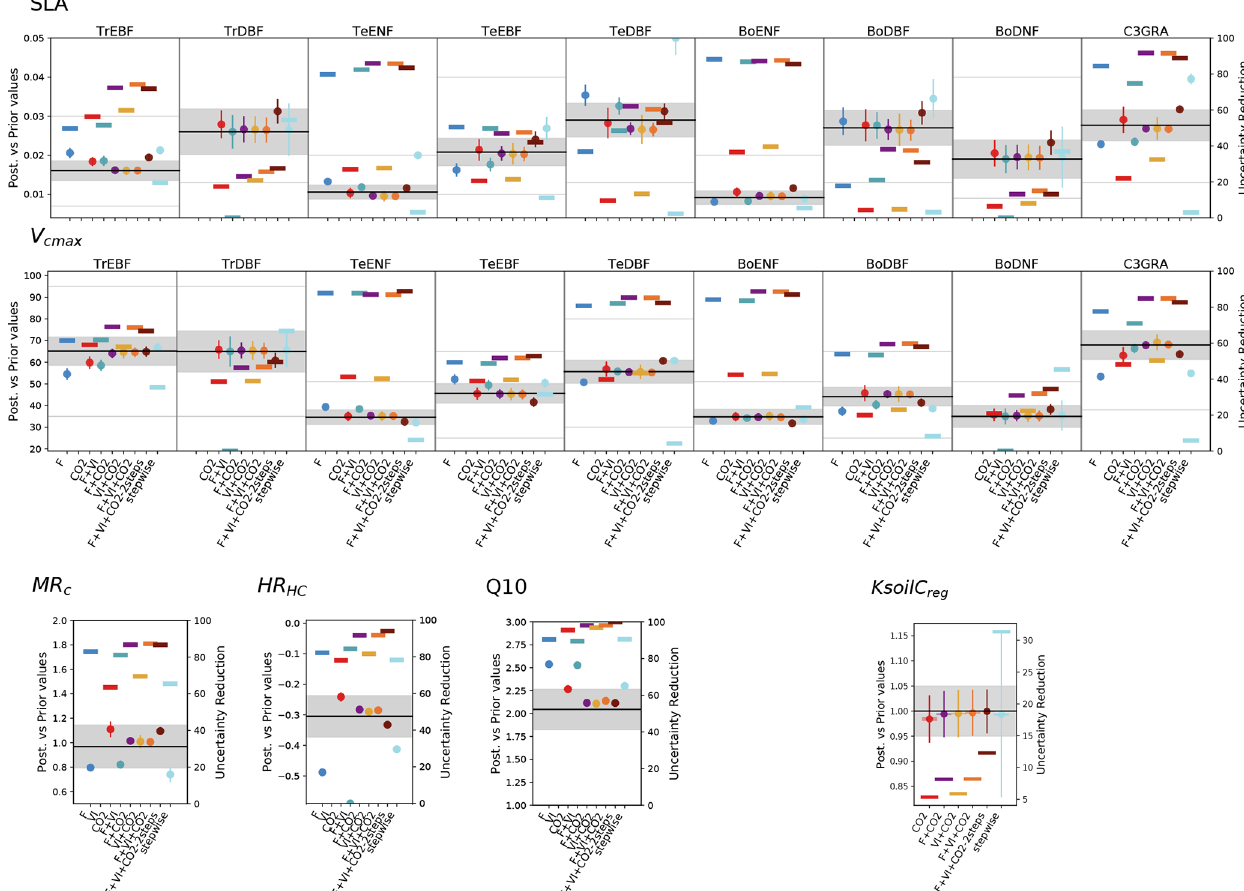
Figure 6. Prior and posterior parameter values and uncertainties for a set of optimized parameters (two PFT-dependent parameters – SLA and V cmax – and four non-PFT-dependent). The prior value is shown as the horizontal black line and the prior uncertainty (standard deviation) as the gray area encompassing it along the x axis. For the PFT-dependent parameters, each box corresponds to a given PFT; empty boxes indicate that this parameter was not constrained for the corresponding PFTs. The white zone (non-dashed area) corresponds to the allowed range of variation. The optimized values are provided for each assimilation experiment (the eight ones considered in this study and the one from Peylin et al. (2016) – “stepwise”); the corresponding posterior errors are displayed as the vertical bars. For each assimilation experiment the uncertainty reduction is also provided (right y axis) as the thick opaque horizontal bars. For K soilC,reg , the posterior values displayed here correspond to the mean over the ecoregions (without Antarctica) considered; the semi-transparent horizontal bars on either side of the posterior values correspond to the standard deviation of the